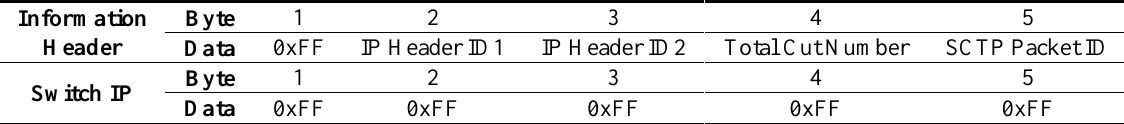
Table 2. Format of self-defined SCTP